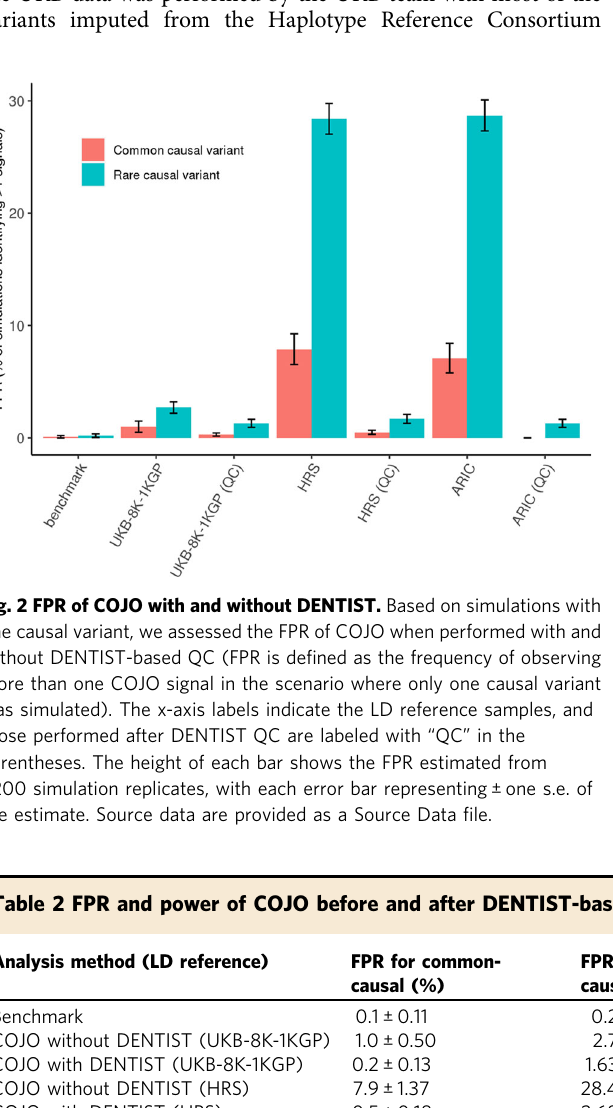
FPR for rare- causal (%) causal